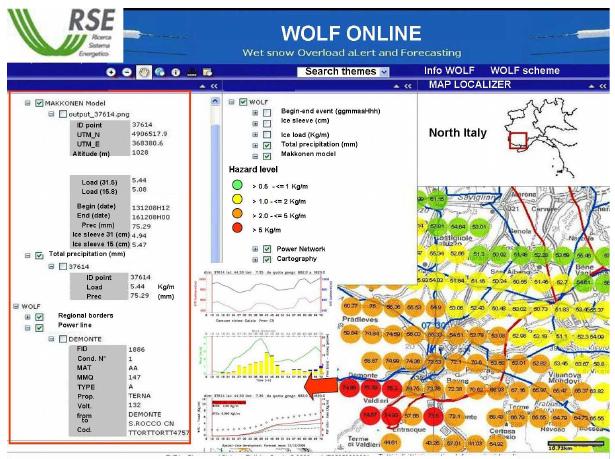
Fig. 3. Web-GIS interactive tool map: wet snow hazard and power line information is available clicking each grid